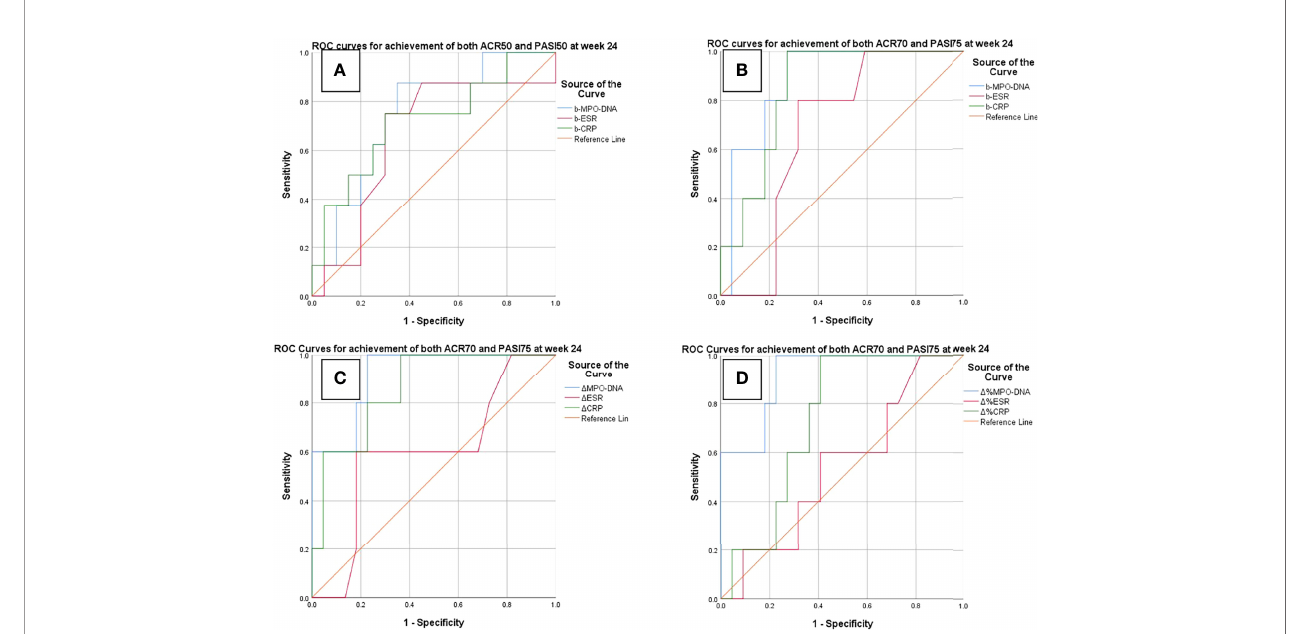
FIGURE 1 | ROC curves for predictions of treatment response at weeks 12 and 24. (A) Baseline serum MPO – DNA, ESR, and CRP to predict achievement of both ACR50 and PASI 50 at week 12. (B – D) Baseline and changes of MPO – DNA, ESR, and CRP to predict achievement of ACR70 and PASI75. b-MPO – DNA/ESR/ CRP, serum MPO – DNA complex/ESR/CRP at baseline; D MPO – DNA/ESR/CRP, reduction of serum MPO – DNA/ESR/CRP at week 12 in absolute value; D MPO – DNA/ESR/CRP%, reduction of serum MPO – DNA/ESR/CRP at week 12 from baseline in